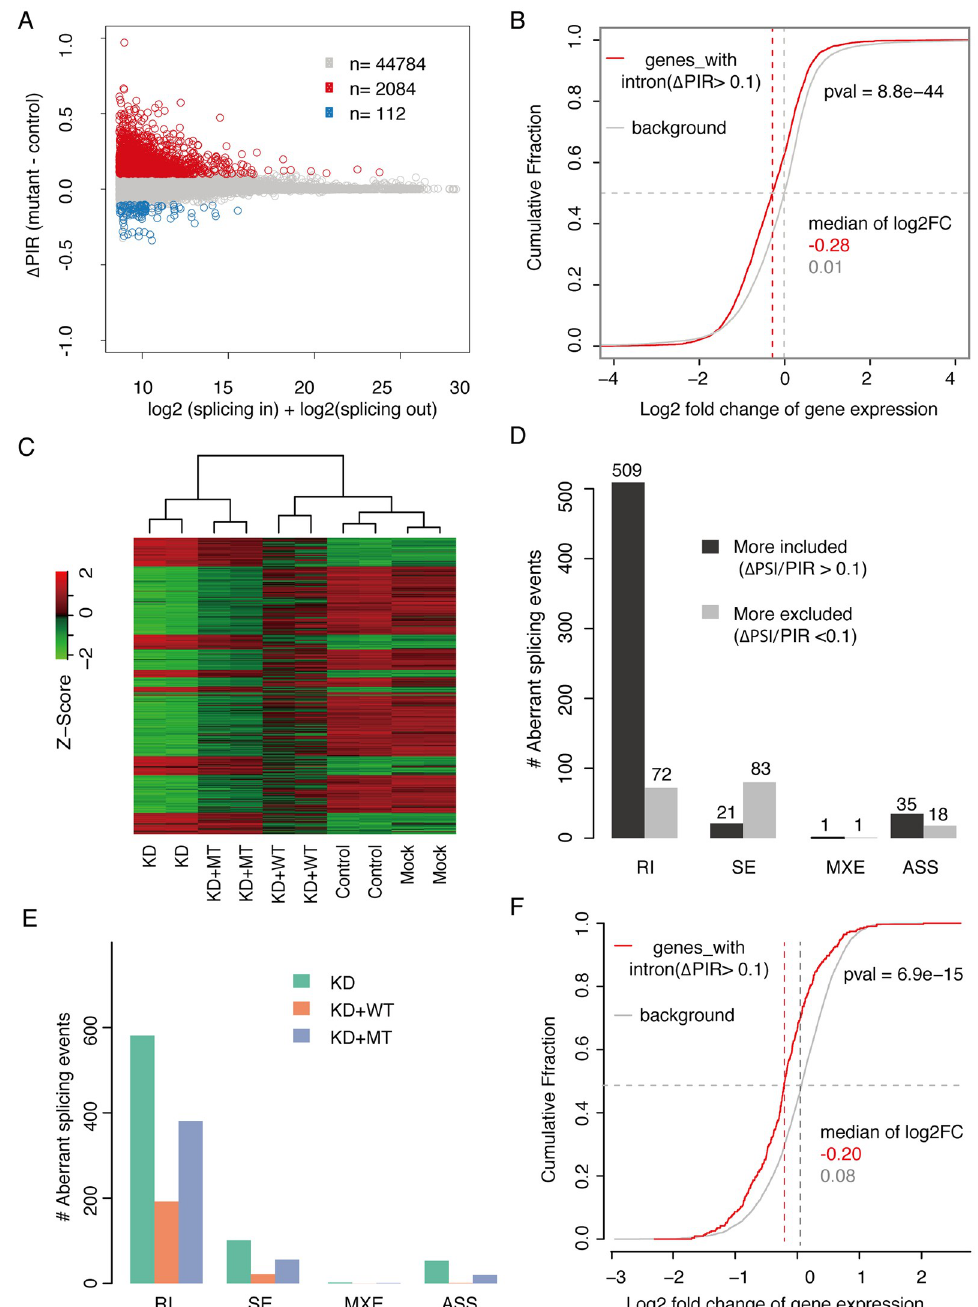
Fig 4. The identified mutation impairs the functionality of SNRPE/SmE in mRNA splicing. (A), The mRNA splicing in patient derived fibroblast cells is impaired. MA plot shows the intron retention was dramatically increased in patient derived fibroblast cells. X axis: the sum of log2 transformed splicing in and splicing out reads number for each intron. Y axis: difference in percentage of intron retention (PIR) between fibroblast derived from the patient (mutant) and healthy control. (B), The intron retention leads to decreased gene expression. Backgrounds are those genes without any intron showing significantly increased retention. (C), Heatmap illustrating expression of 11670 protein coding genes (average RPKM > 1) in HEK293 cells among different experimental conditions. Control, control siRNA; KD, SmE siRNA; KD +WT, SmE siRNA+wild type SmE; KD+Mut, SmE siRNA+mutant SmE. (D), Number of aberrant splicing events induced by SNRPE/SmE knockdown (KD) comparing with control. RI, retained intron; SE, skipped exon; MXE, mutually exclusive exon; ASS, alternative splice site. (E), Numbers of aberrant splicing events in KD, KD+Mut and KD +WT comparing to control. (F), The intron retention leads to decreased gene expression. Backgrounds are those genes without any intron showing significant increased retention.